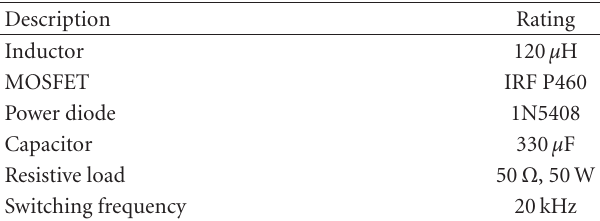
Table 5: Component values of DC-to-DC boost